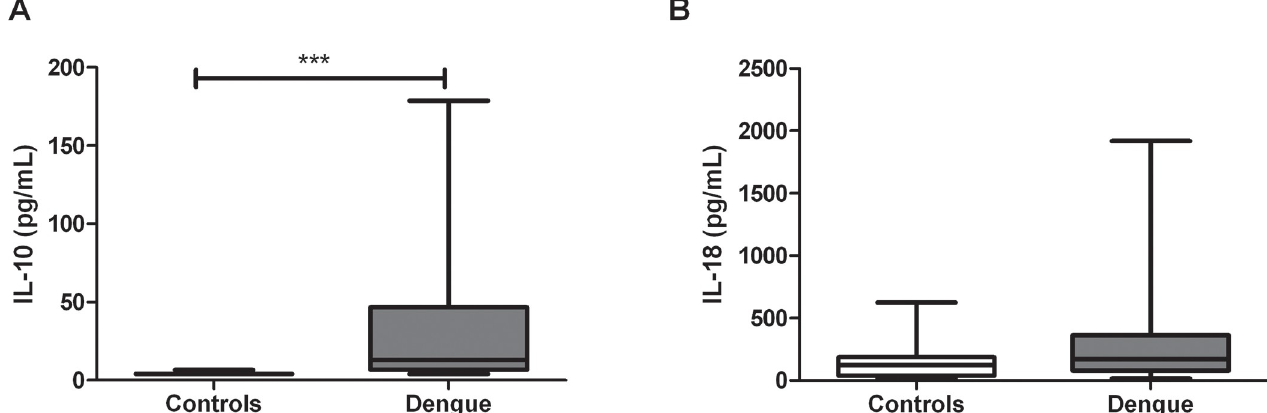
Fig 5. Serum levels of IL-10 and IL-18 in dengue patients. Serum levels of (A) IL-10 and (B) IL-18 were quantified by ELISA (in duplicates). The results are presented as medians with maximum and minimum values (box and whisker plot). The statistical comparison was made using the Mann Whitney U test with a confidence level of 95%. Significant differences are represented at the top of the figure ( ��� p < 0.001).